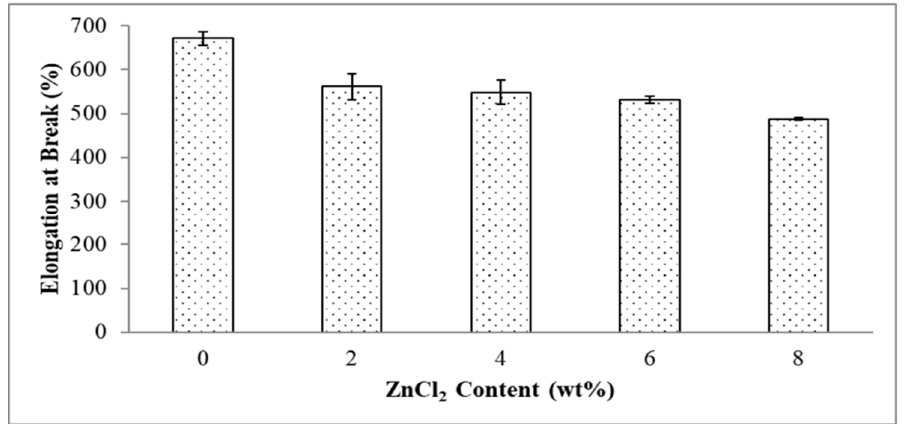
Figure 6. Effect of ZnCl 2 content on elongation at break of EVA/CWF